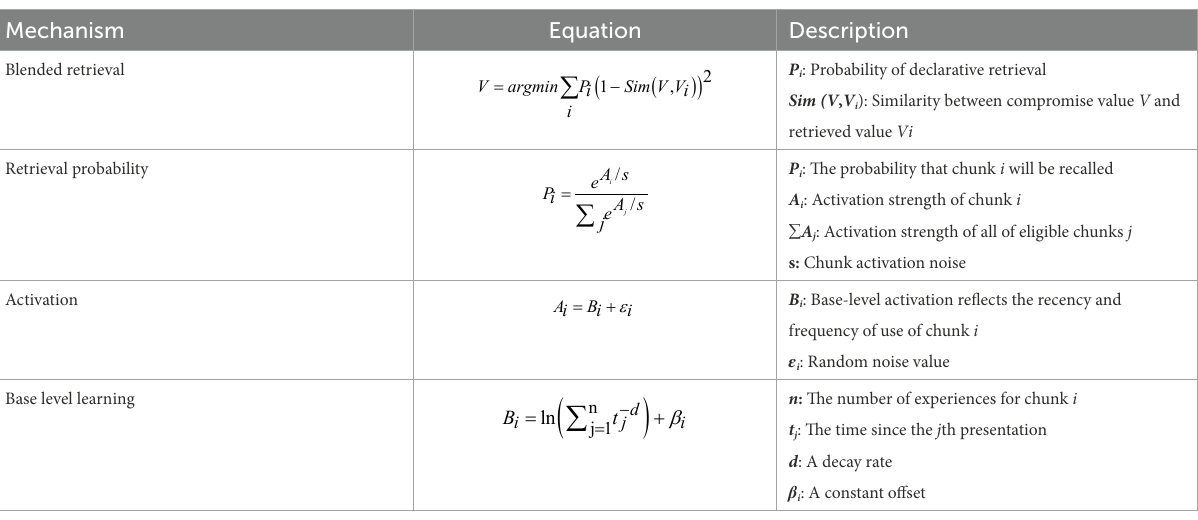
TABLE 1 Core ACT-R mechanisms used in the